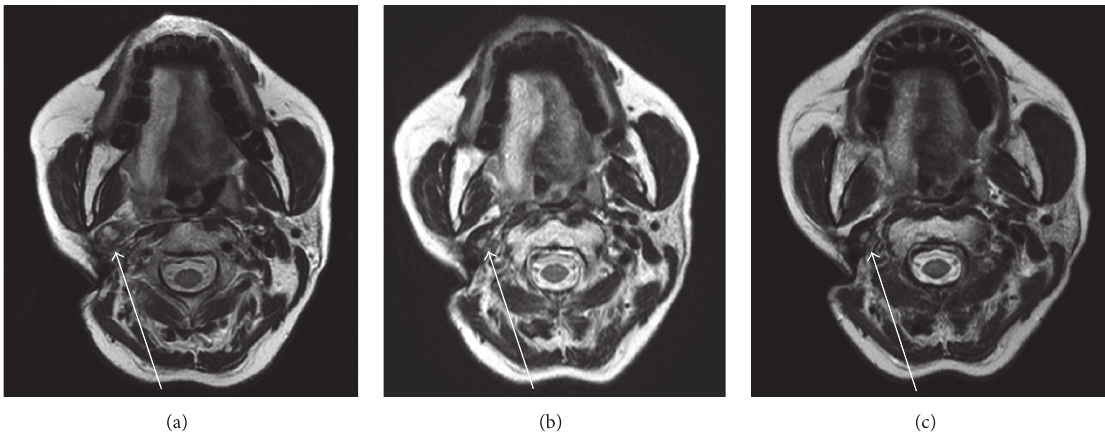
Figure 1: Magnetic resonance T2-weighted imaging findings. (a) Postsurgical status: a recurrent lymph node metastasis from a papillary thyroid carcinoma in the right parapharyngeal space is shown (white arrow). (b) Three months after stereotactic radiation therapy (SRT) using the CyberKnife radiotherapy system, the lymph node metastasis is remarkably reduced. (c) Twelve months after SRT, the reduced lymph node metastasis has not changed. No recurrences were recognized, which indicates therapeutic effectiveness.